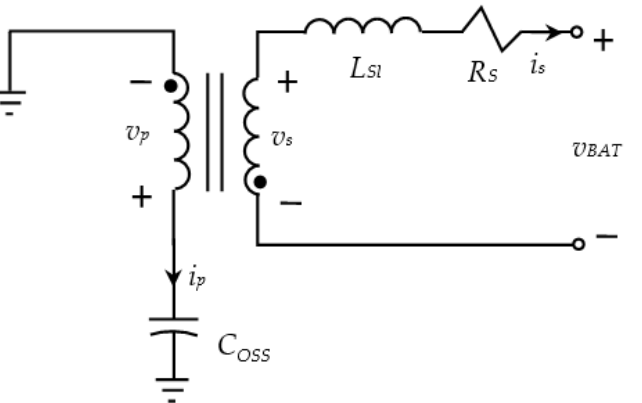
Figure 4. AC Equivalent circuit for the current flowing to the snubber and the battery when the secondary diode is on.